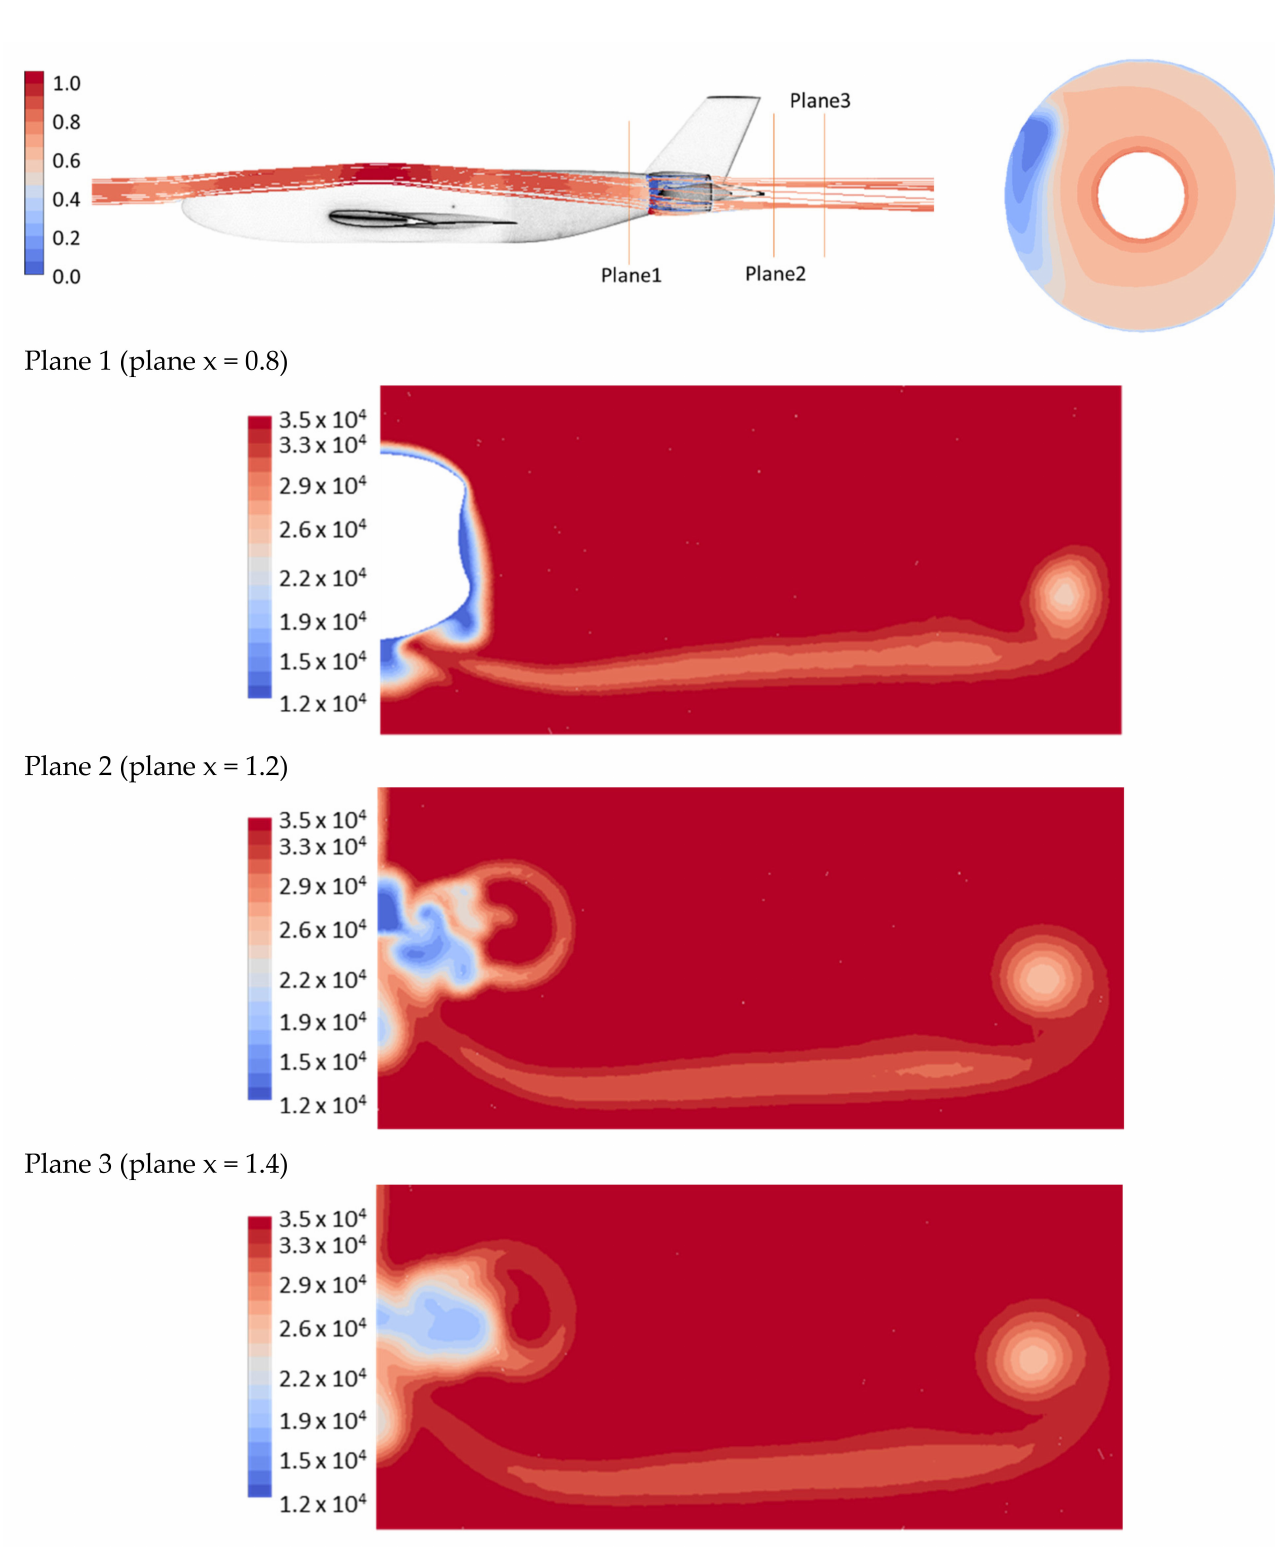
Figure 20. Pathlines towards the inlet of the engine ( top left ), the contour of the Mach number in the plane of fan inlet ( top right ), and the contours of the total pressure [Pa] in the planes of interest (From the second to the last: Plane 1, Plane 2 and Plane 3), results from the 3D simulation of short